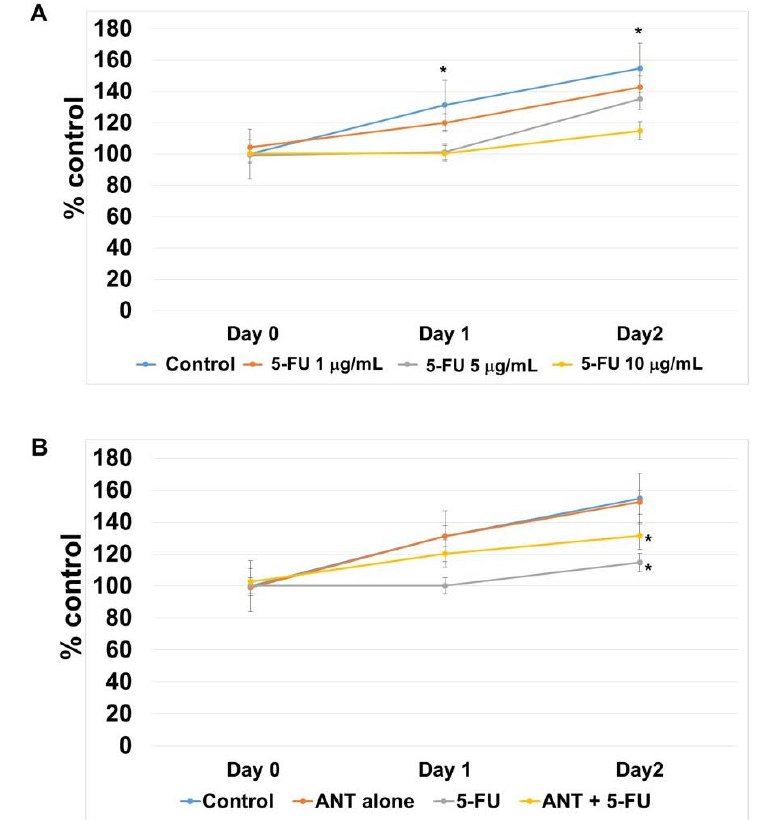
Figure 7. The effect of ANT-rich extract on 5-FU-induced cell growth suppression. Viable cells were estimated by 3-[4,5-dimethylthiazol-2-yl]-2,5 diphenyl tetrazolium bromide (MTT) assay and expressed as percentage of control cells. ( A ) Cells were grown in medium supplemented with 5-FU (1, 5 and 10 μg/mL) for 2 days. 5-FU did not exert cytotoxic effects on oral keratinocytes. Data are expressed as the mean ± SD. * p < 0.05 vs. 5 and 10 μg/mL of 5-FU treatment; ( B ) cells were pretreated with 1 mg/mL ANT-rich extract and exposed to 5-FU (10 g/mL) for 2 days. * p < 0.05 vs. control.